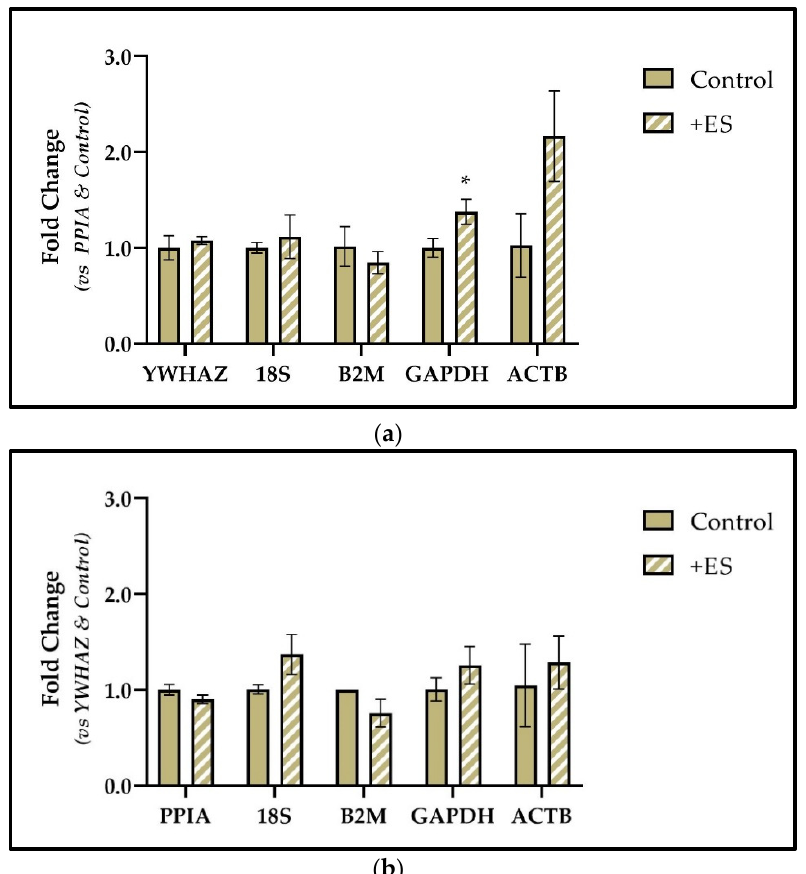
Figure 5. Gene expression analysis performed using the ∆∆ C T method in unstimulated controls (Control) and cells stimulated for 60 min per day (+ES). Expression is normalized to the control and to the gene determined to be the most stable for the respective seeding density by NormFinder. Each graph corresponds to the two seeding densities used: ( a ) 5000 cells/cm 2 , and ( b ) 10,000 cells/cm 2 . * p < 0.05 versus control of the same gene. Each gene was analyzed separately using an unpaired T-test; N = 2 for control, N = 3 for +ES group.